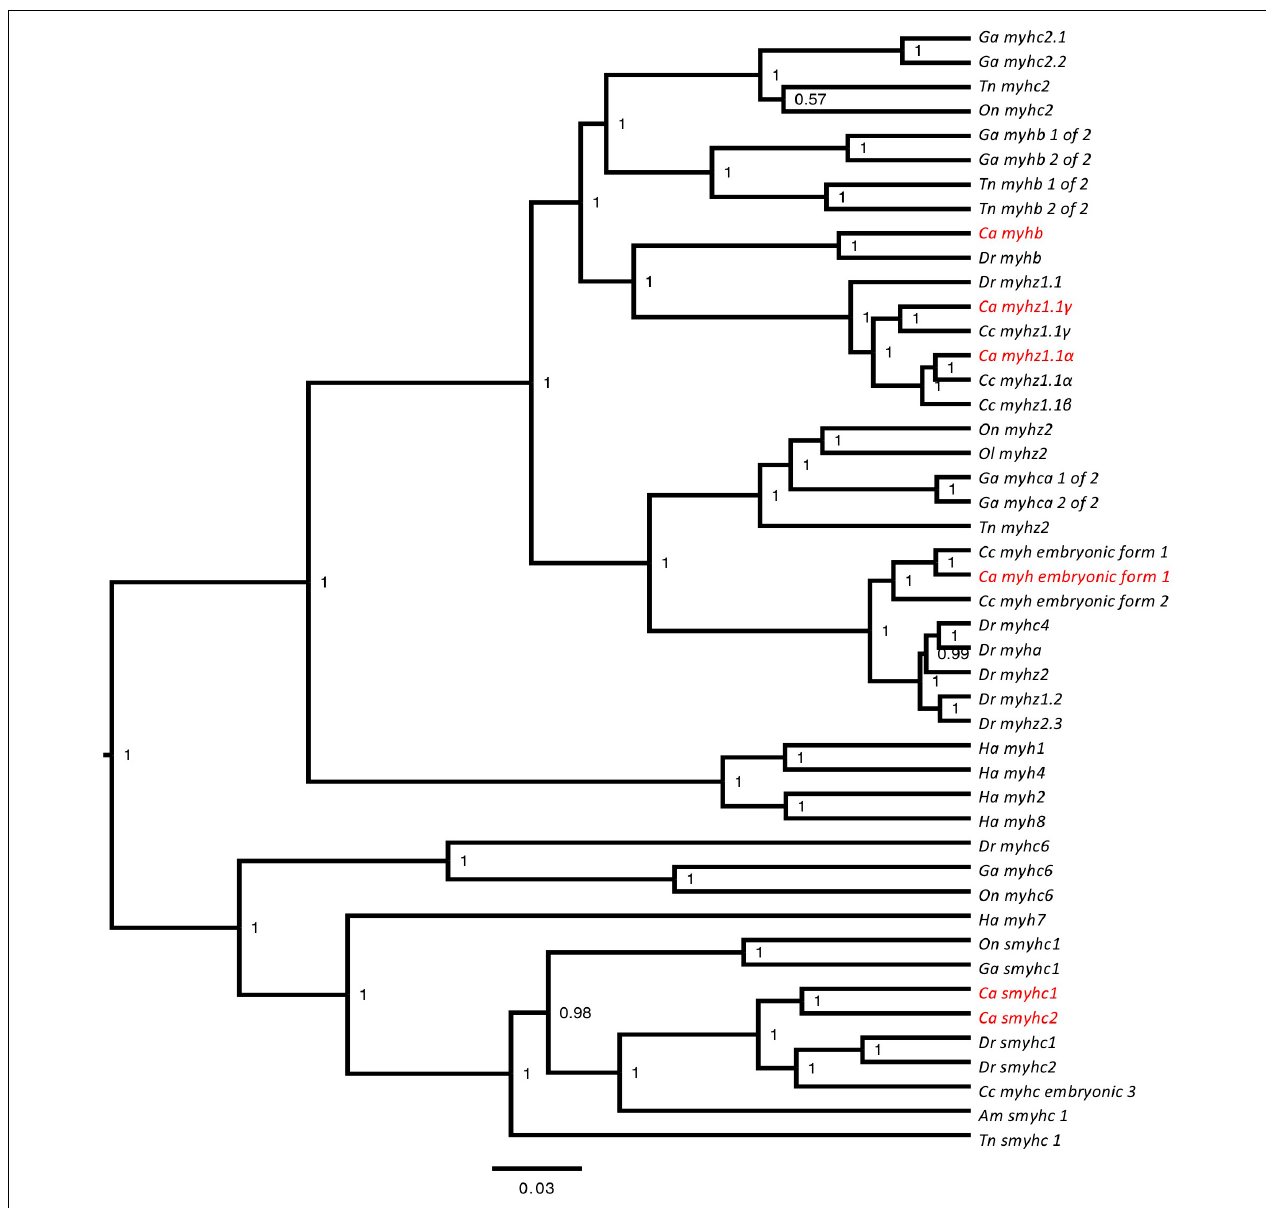
FIGURE 1 | Phylogenetic tree constructed for myosin heavy chain genes. Bayesian phylogenetic relationships for the myosin heavy chain orthologs. Phylogenetic tree node numbers represent posterior values. To facilitate interpretation, goldfish orthologs ( Carassius auratus, Ca ) are highlighted in red. Myosin heavy chain orthologs for zebrafish ( Danio rerio, Dr ), stickleback ( Gasterosteus aculeatus, Ga ), common carp ( Cyprinus carpio, Cc ), green spotted pufferfish ( Tetraodon nigroviridis, Tn ), tilapia ( Oreochromis niloticus, On ), medaka ( Oryzias latipes, Ol ), and human ( Homo sapiens, Ha ) were also